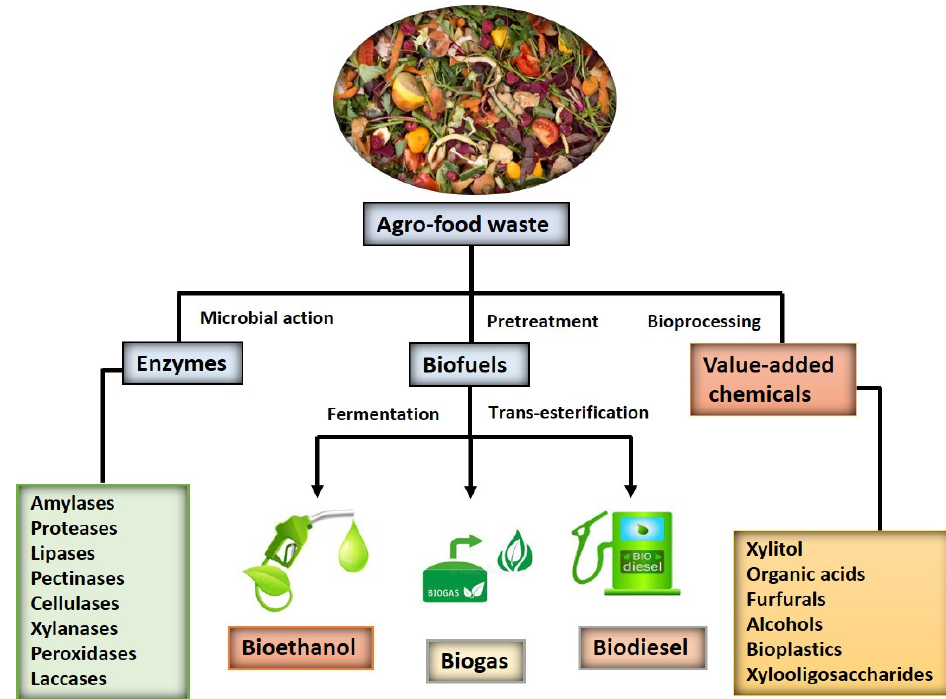
Figure 2. Agro-industrial food waste as a raw material for the production of different bioproducts.